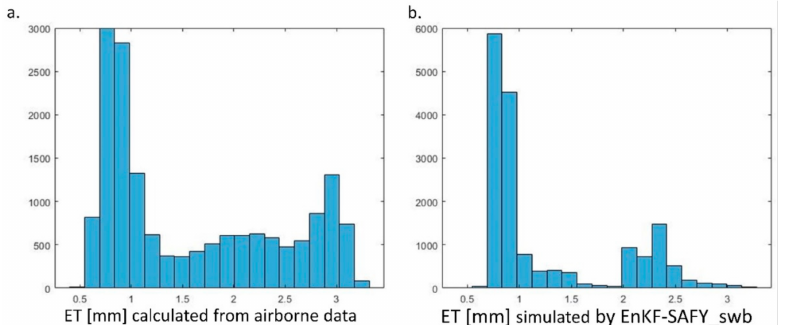
Figure 13. ( a ) Histogram of daily ET (expressed in mm) calculated from airborne data; ( b ) histogram of daily ET (expressed in mm) simulated by EnKF-SAFY_swb.